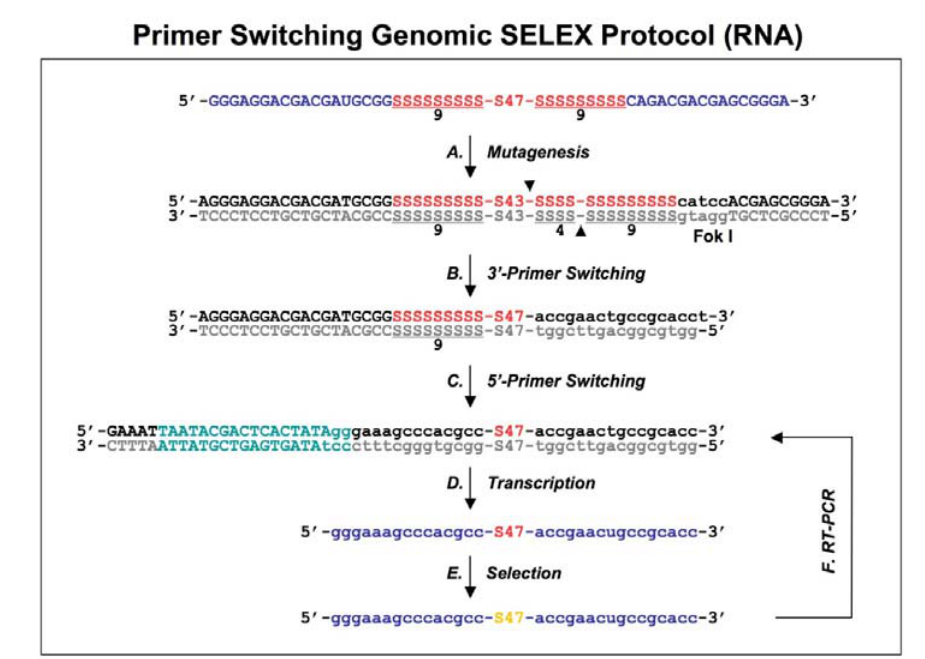
Figure 2. Diagram of primer-switching genomic SELEX. The third round RNAs selected by regular selection are reverse transcribed to cDNAs, and PCR amplified by 5’primer and modified 3’ primer to a introduce Fok I restriction site (indicated in lower case, with its cutting sites indicated by black arrowheads; A). After Fok I digestion the overhang at the cut end of the library DNA is extended with Klenow enzyme, and blunt-end ligated to the new 3’ fixed sequence indicated in lower case (B). The steps of A and B are repeated but this time for the 5’ end, to generate a new transcription template (C; the T7 RNA polymerase promoter is indicated in green) for the following transcriptions, selections and re-amplifications (D-F). This protocol is distilled from Shtatland et al .